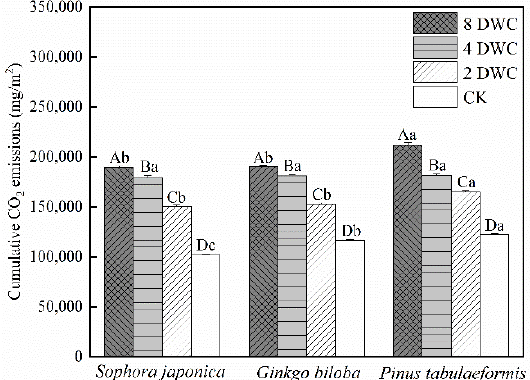
Figure 3. Effects of drying and rewetting cycle (DWC) frequencies on the cumulative CO 2 emission fluxes among different woodland soils. Note: uppercase letters represent the comparison of cumu- lative CO 2 emission fluxes among the different DWC frequencies within the same soils, whereas lowercase letters represent the comparison of cumulative CO 2 emission fluxes among the three woodland soils under the same DWC frequency.